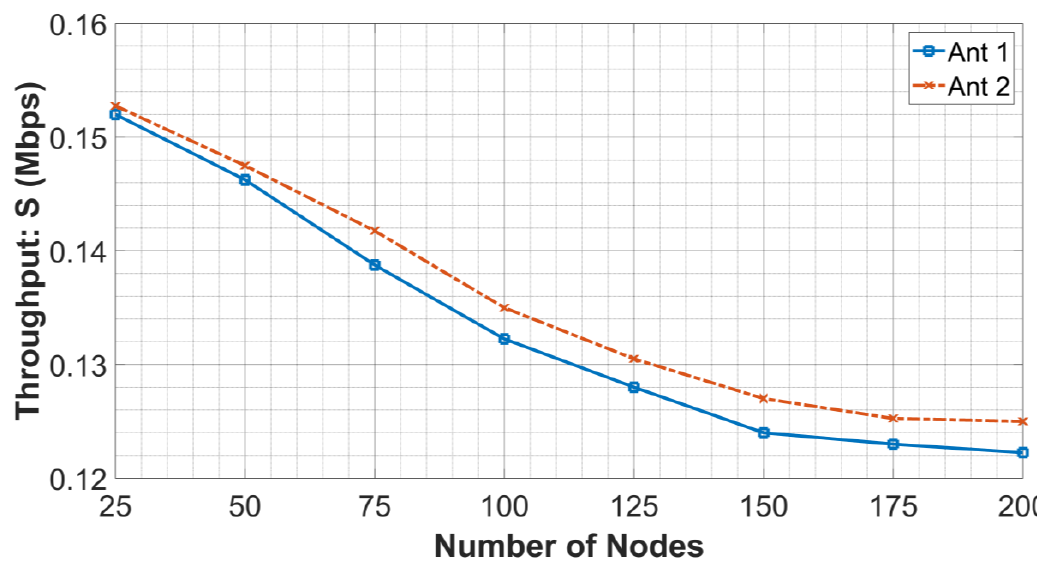
Figure 12. Impact of number of nodes on maximum throughput.